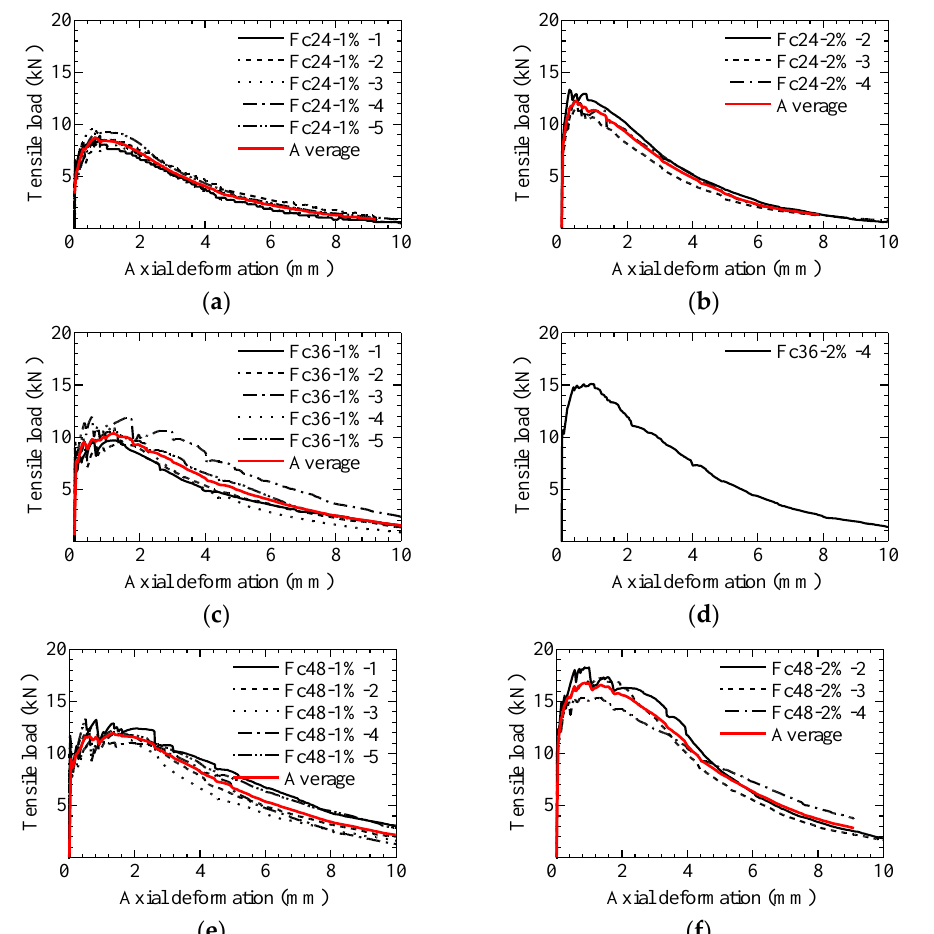
Figure 7. Tensile load-axial deformation relationship in uniaxial tension test: ( a ) Fc24-1%; ( b ) Fc24-2%; ( c ) Fc36-1%; ( d ) Fc36-2%; ( e ) Fc48-1%; ( f ) Fc48-2%.